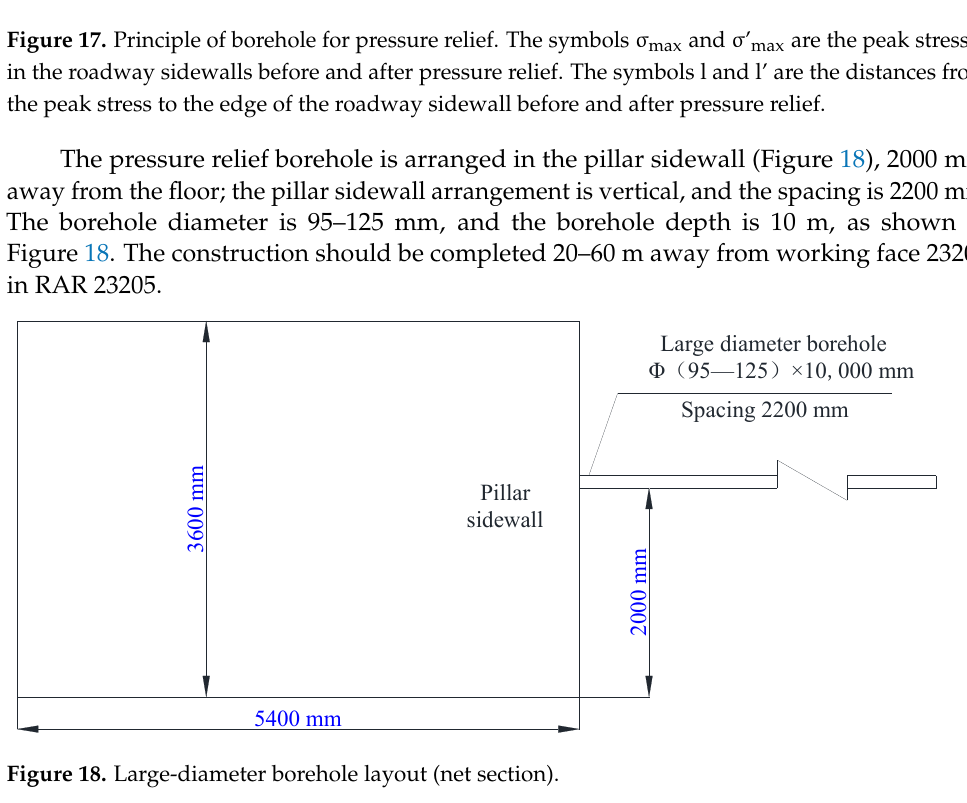
Figure 17. Principle of borehole for pressure relief. The symbols σ max and σ ’ max are the peak stresses